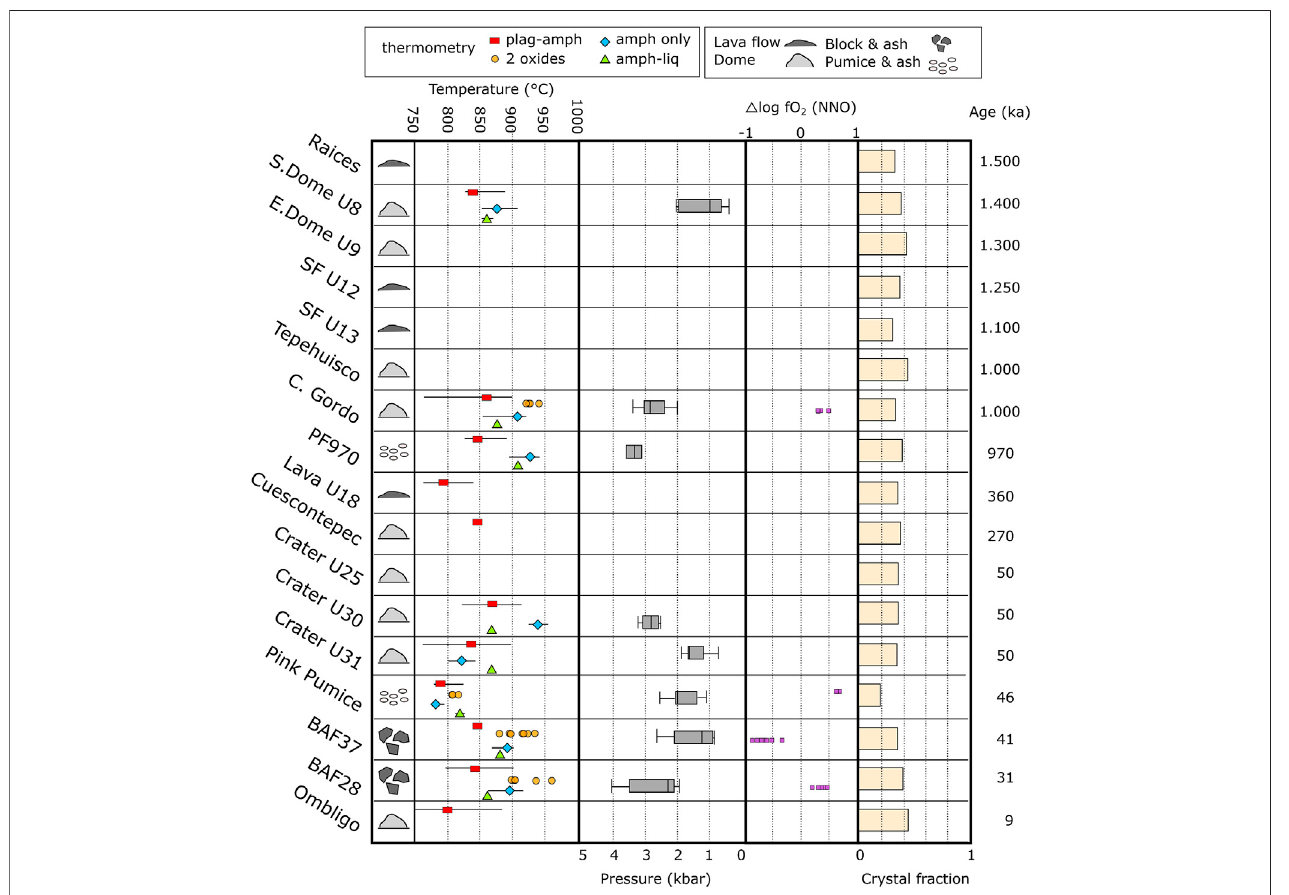
FIGURE 9 | Geothermobarometry and crystallinity of Nevado de Toluca samples as a function of time. The deposit type of the sample material (Pumice and ash fl ow, Block and ash fl ow, dome or lava fl ow) is indicated on the left side of the plot. Temperature estimates by plagioclase-amphibole (Holland and Blundy, 1994) of averageoutermostrimcompositionsareshownasredrectangleswith2standarddeviationerrorbars.Amphibole-liquidtemperatures(Putirka,2016)werecalculatedby using outmost amphibole compositions from euhedral crystals and average groundmass analyses of the corresponding thin section (green triangles). Amphibole temperatures were also calculated using a calibration independent of melt chemistry (Putirka, 2016; blue diamonds), which for most samples shows agreement within errorstoamphibole-liquidtemperatures.Fe – Tioxidetemperatures andoxygenfugacity (relativetoNickel-Nickel-Oxide)areshownasorangecirclesand purplesquares respectively and were calculated using Ghiorso and Evans (2008). Boxplots of pressure (kbar) were calculated using outermost amphibole rims and average groundmasscompositionsfordifferentsamplesfollowingPutirka(2016).Calculationdetailsandassociateduncertaintiesarediscussedinthemaintext.Crystalfractions shown on the right side were estimated by point counting.